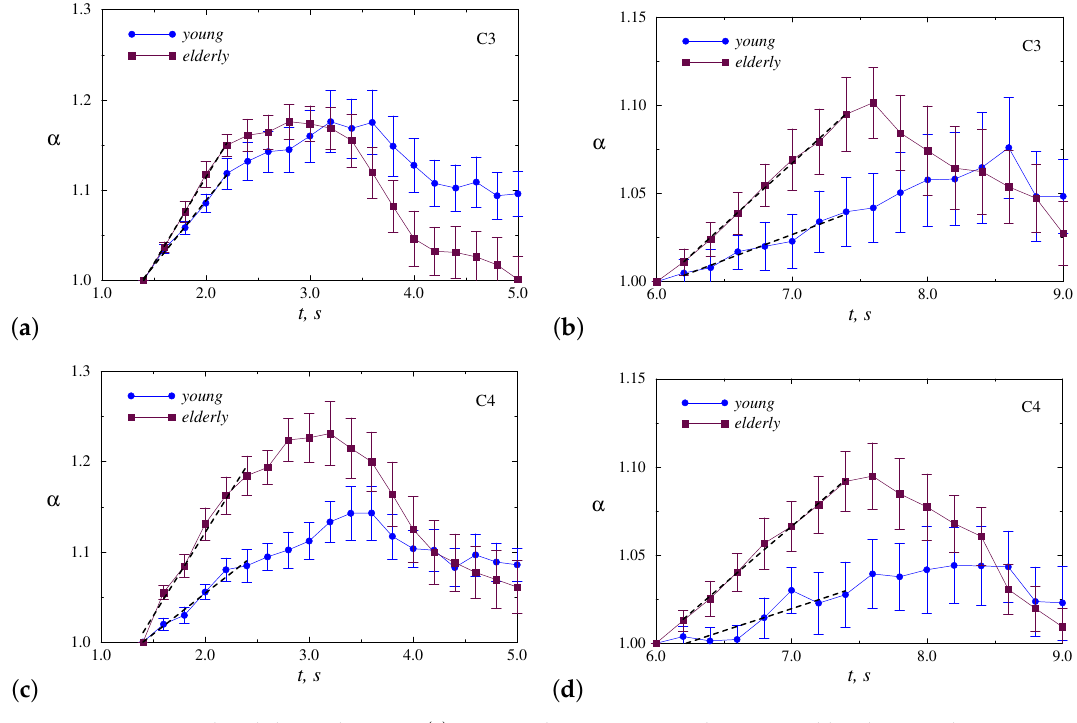
Figure 6. Normalized dependencies α ( t ) averaged over motor tasks executed by the non-dominant hand (LH), which are presented for two segments: clenching ( a , c ) and unclenching ( b , d ) the hand. The results are shown for the channels C 3 ( a , b ) and C 4 ( c , d